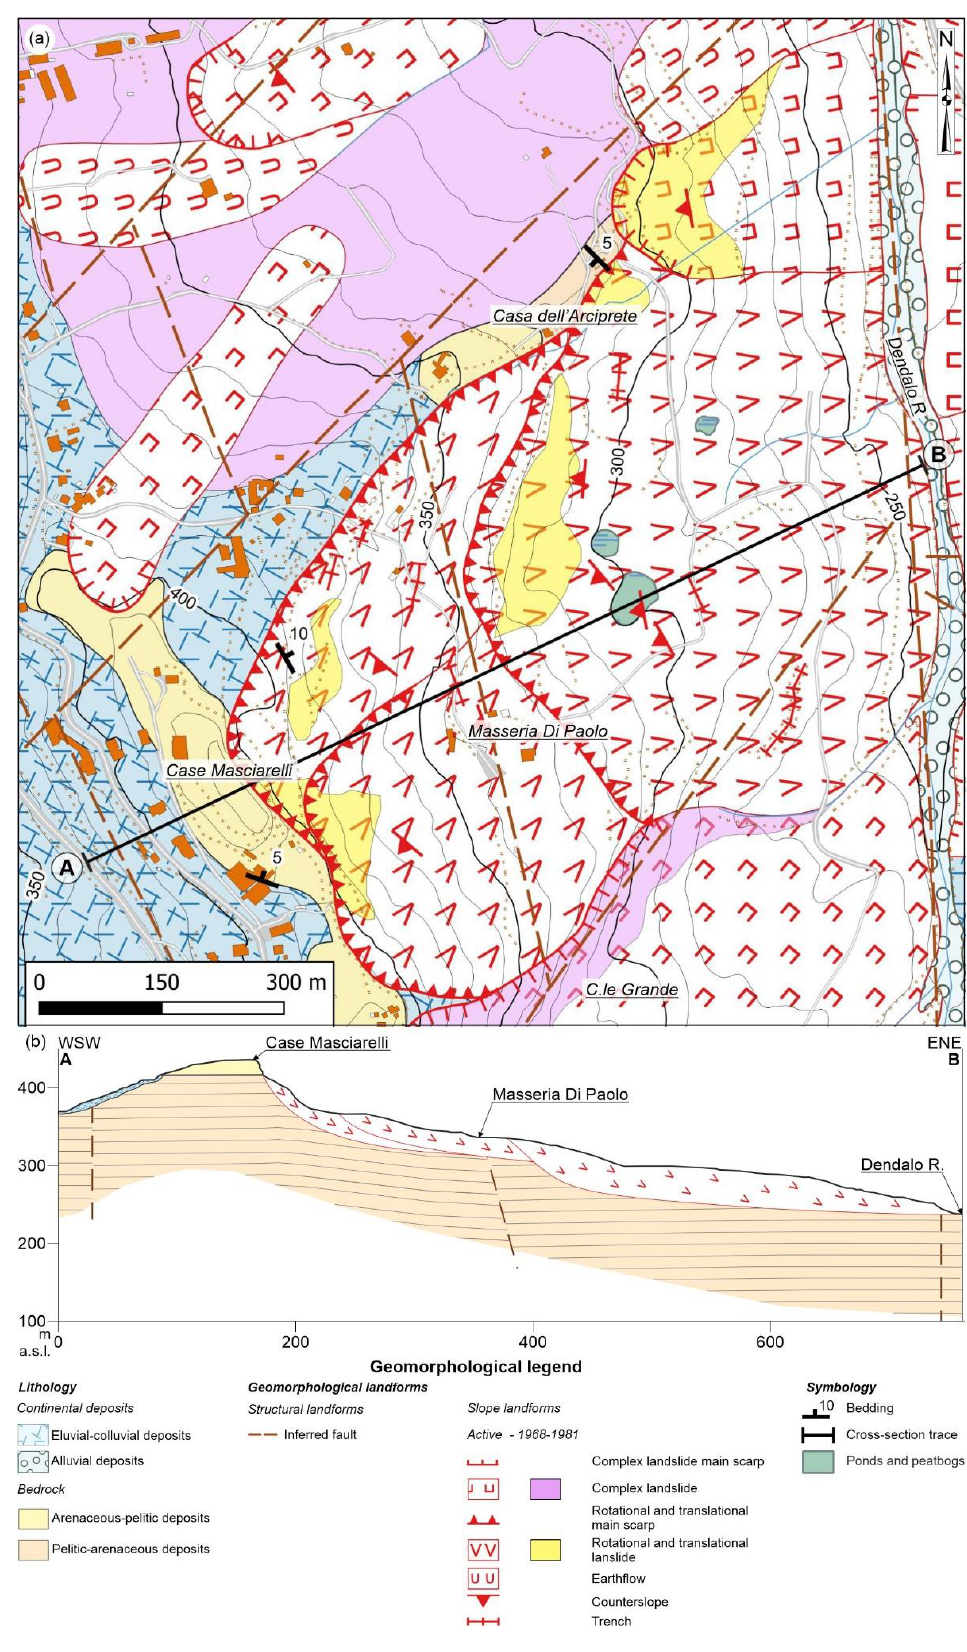
Figure 6. San Martino sulla Marruccina: ( a ) multitemporal geomorphological map (derived from unpublished data and modified and updated from [79–81]); ( b ) geomorphological cross-section.